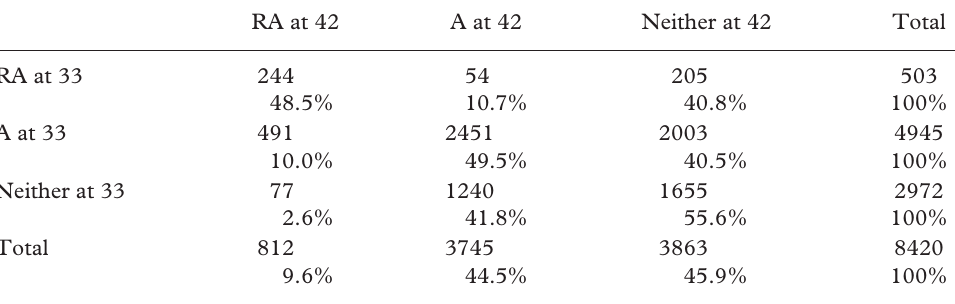
Table 2. Transition matrix for changes between clusters at ages 33 and 42